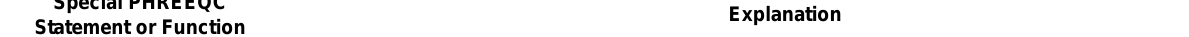
Table 8. Special Basic statements and functions for